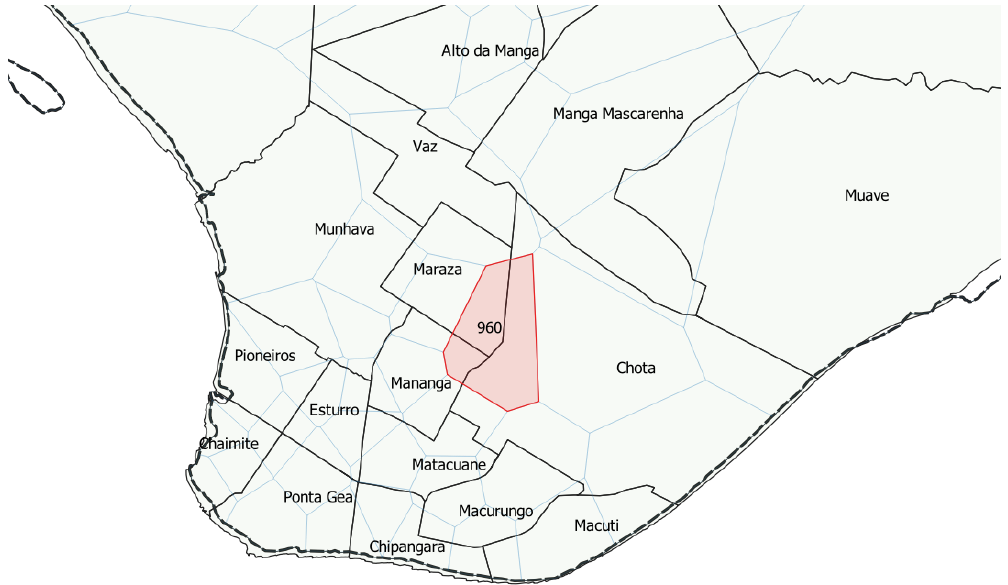
Figure 5. Example of overlay between voronoi and neighborhood administrative boundaries from study